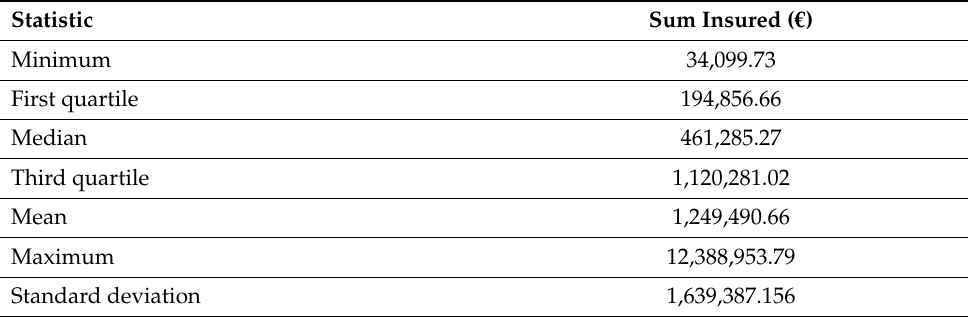
Table 1. Descriptives of the sum